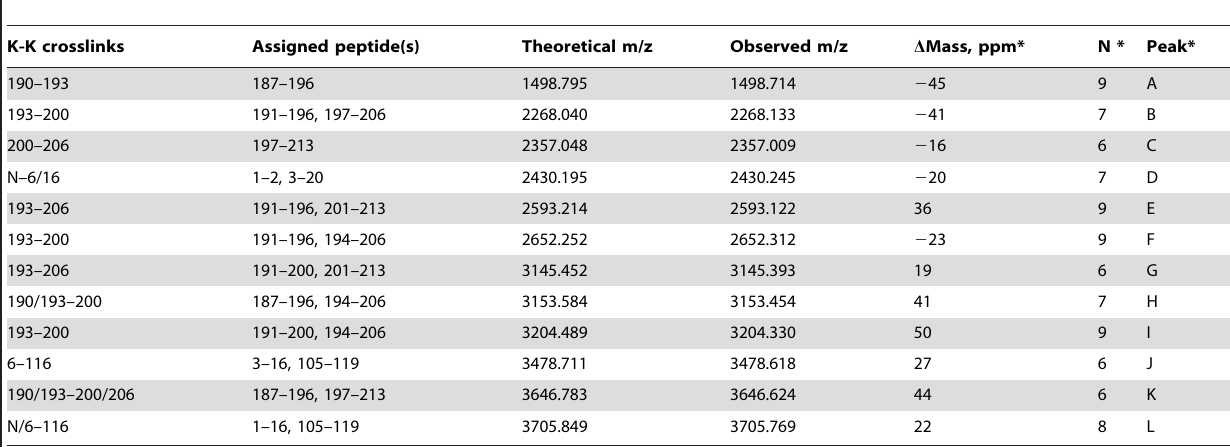
Table 1. Intramolecular crosslinks identified by mass spectrometric studies of monomeric GlyBP bands.